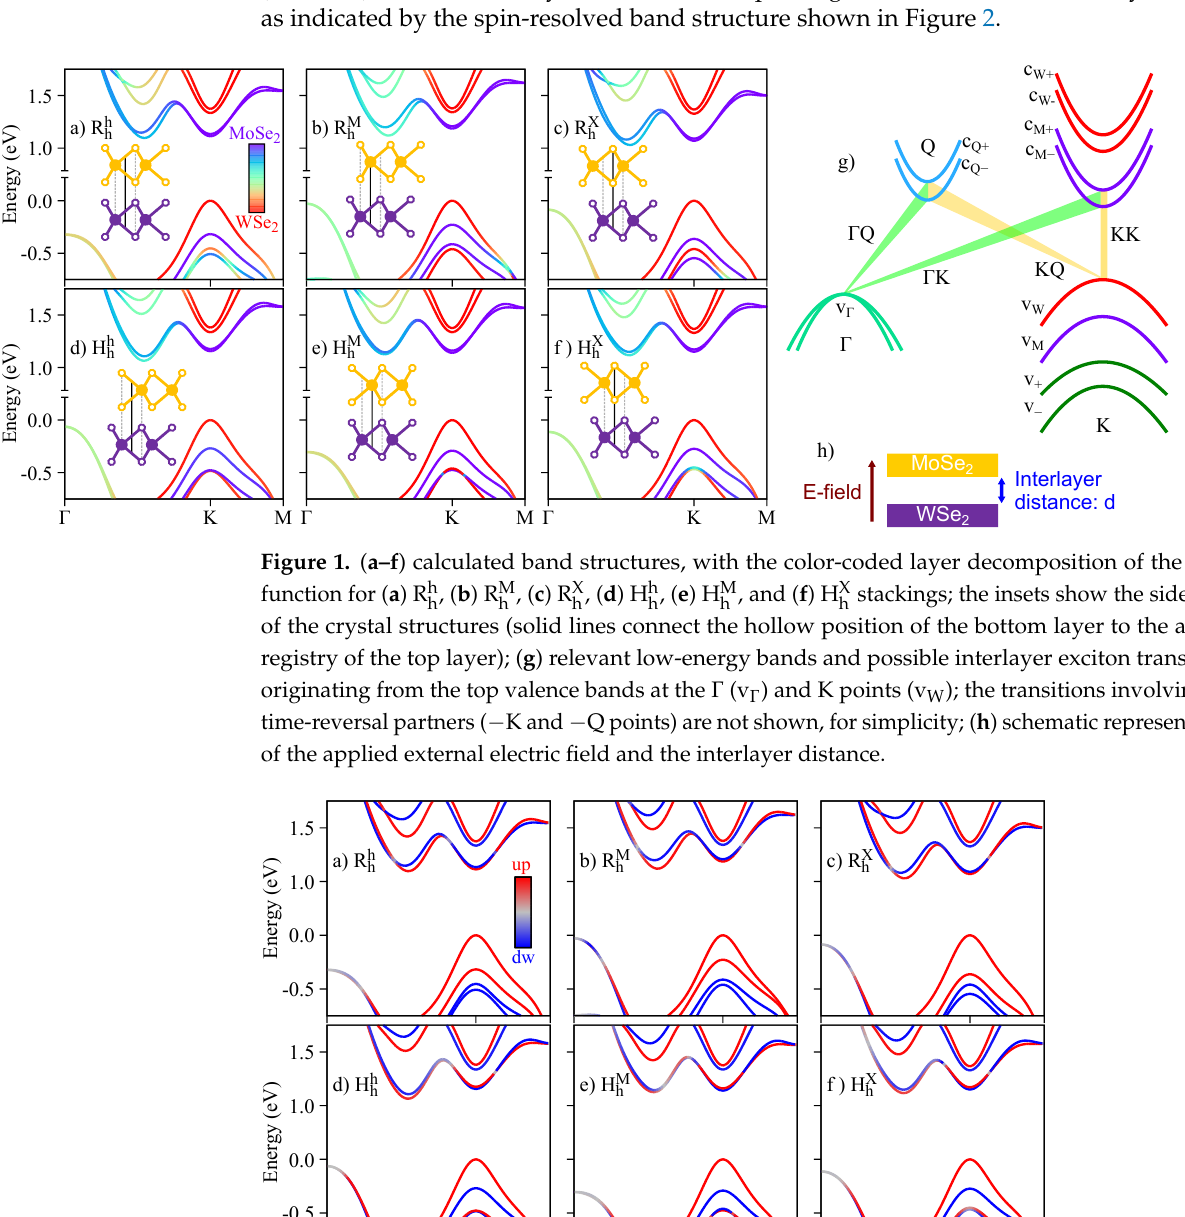
(0 ◦ or 60 ◦ ) between the layers, the relative spin degree of freedom is certainly affected, as indicated by the spin-resolved band structure shown in Figure 2.